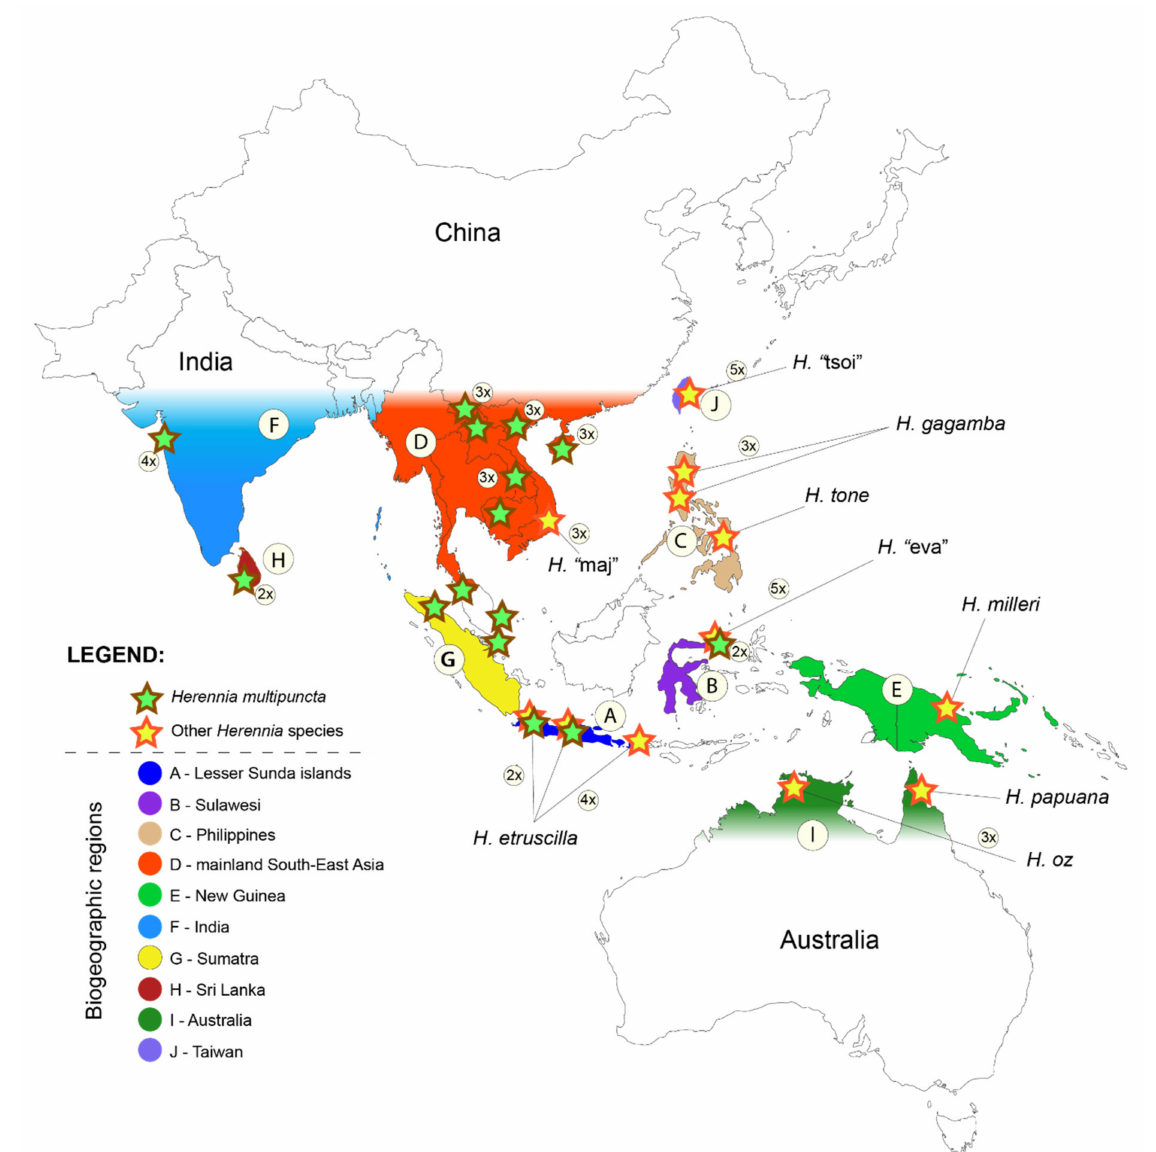
Figure 1. Sampling locations of Herennia individuals used in this study. Encircled numbers denote the number of individuals from the same sampling location. Geographic areas, used for historical biogeography inference ( A – J ), are